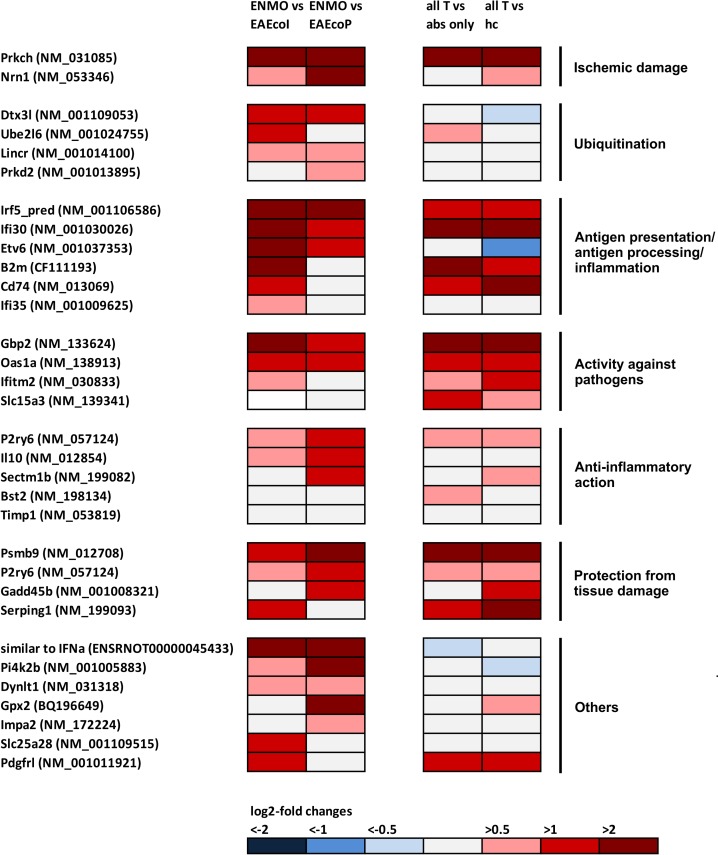
Footprints of the action/production of type I interferons in ENMO and EAE, as revealed by microarray analysis.In the first column of pairwise comparison of log2-fold changes in gene expression, mean values were compared between rats receiving T cells and NMO-IgG (ENMO, n = 5) and their counterparts receiving T cells and subcuvia as control IgG (EAEcoI, n = 5) or T cells and PBS (EAEcoP, n = 5). In the second column of pairwise comparison of log2-fold changes in gene expression, mean values were compared between a group containing all ENMO plus EAEcoI plus EAEcoP animals (n = 15, “all T”) and a group containing animals injected with antibodies only (“abs only” (5 animals with NMO-IgG plus 5 animals with subcuvia as control IgG) or containing healthy control animals only (“hc”, n = 3). The differentially expressed genes shown here belong to 7 different, large groups, i.e. to ischemic damage, ubiquitination, antigen presentation/antigen processing/inflammation, activity against pathogens, anti-inflammatory action, protection from tissue damage, and unknown function (“others”). In experimental autoimmune neuromyelitis optica (ENMO), 31 differentially expressed genes are found. 19/32 differentially expressed genes were already upregulated in all T cell-induced CNS inflammations compared to all other non-inflammatory controls.